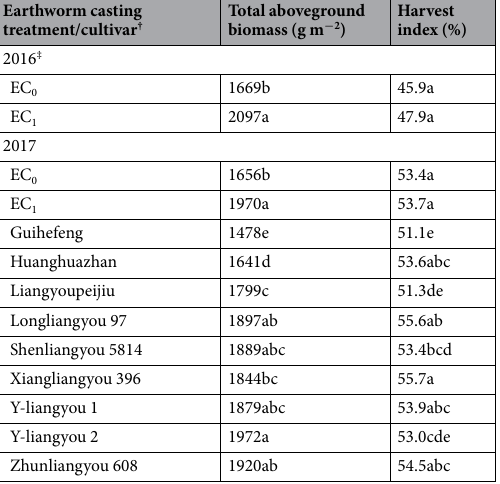
Table 3. Total aboveground biomass and harvest index in rice as affected by earthworm castings in 2016, and by earthworm castings and cultivars in 2017. Within a column for earthworm casting treatments in each year and for cultivars in 2017, data with the same letters are not significantly different at the 0.05 probability level (LSD test). † EC 0 and EC 1 represent absence (0 kg m − 2 ) and presence of earthworm castings (17 kg m − 2 ), respectively. ‡ Data are the means across three N rates in